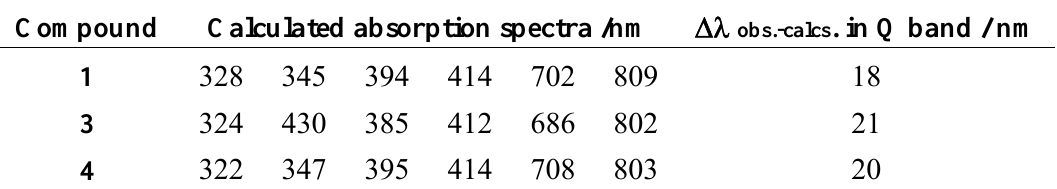
Table 1. The calculated absorption spectra from PPP molecular orbital method.